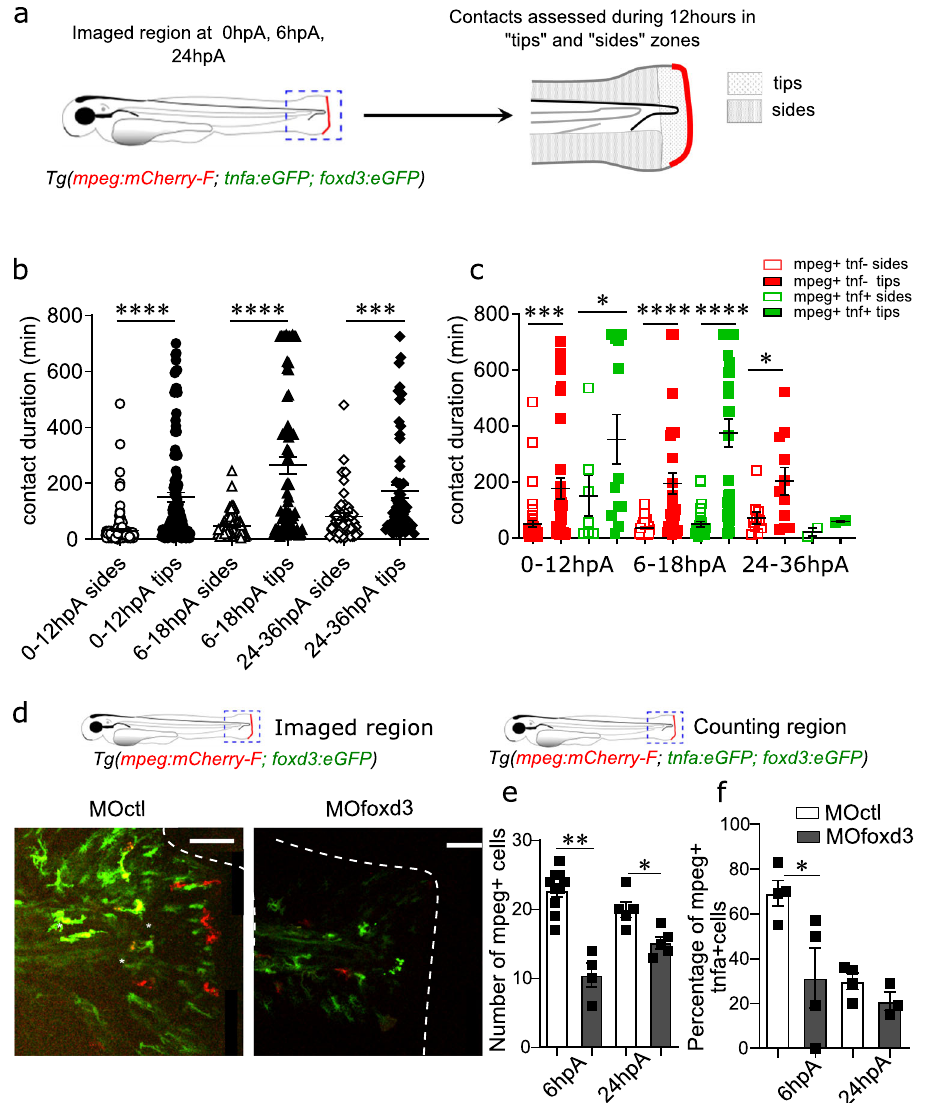
Fig. 4 Foxd3 + NCdC interact with and promote the recruitment and activation of macrophages in the blastema. a Schematic representation of the tip and sides where macrophages and foxd3 + NCdC contacts were assessed for 12 h by live confocal microscopy at 0hpA, 6 hpA, 24 hpA in Tg(mpeg:mCherry- F; tnfa:eGFP-F; foxd3:eGFP-F) larvae. b Quanti fi cation of the duration of macrophages and foxd3 + NCdC contacts in the tips and sides during 12 h in Tg(mpeg:mCherry-F; tnfa:eGFP-F; foxd3:eGFP-F) larvae, at 0hpA ( n = 192 for the sides group, n = 124 for the tips group), 6 hpA ( n = 105 for the sides group, n = 71 for the tips group), and 24 hpA ( n = 54 for the sides group, n = 60 for the tips group) (mean number of contact durations ± SEM, from at least n = 5 biologically independent larvae per time points, Kruskal Wallis test with Dunn ’ s test for multiple comparison were performed, **** p < 0.0001,). c Quanti fi cation of the contact duration between macrophages ( mpeg + and tnfa + ) and foxd3 + cells in tips and sides during 12 h in the transgenic larvae, at 0 hpA, 6 hpA, 24 hpA (mean number of contact durations ± SEM, Kruskal-Wallis test and Dunn ’ s test for multiple comparison were performed, * p < 0.05, *** p < 0.001, **** p < 0.0001, n = 3 biologically independent larvae per time point). d Fluorescence microscopy images of 3 dpf Tg(mpeg1:mCherry-F/ tnfa:eGFP-F/foxd3:eGFP-F) larvae injected with MO ctl or MO foxd3 (Scales bars = 50 µ m). e Number of macrophages recruited at the wound site at 6 hpA and 24 hpA in MO ctl- and MO foxd3 -injected Tg(mpeg1:mCherry-F) larvae (graph represents mean number of positive cells ± SEM, n = 10 biologically independent larvae for the control group at 6 hpA, n = 4 larvae for the MO foxd3 group at 6 hpA, n = 5 larvae for both control and morphant group at 24hpA, one-tailed Mann-Whitney test was performed, p = 0.0028 for the 6 hpA time point, p = 0.0106 for the 24 hpA time point, * p < 0.05, ** p < 0.01). f Percentage of pro-in fl ammatory macrophages at the wound site at 6 hpA and 24 hpA (graph represents mean number of mpeg + tnfa + cells ± SEM, n = 4 biologically independent larvae per groups , one − tailed Mann-Whitney test was performed, p = 0.0286 for the 6 hpA time point, * p < F/tnfa:eGFP-F/foxd3:eGFP-F) 3 dpf larvae, we monitored the long-lasting contacts occurred preferentially in the tip region interactions between foxd3 + NCdC and macrophage subpopula- (Fig. 4b). Moreover, the long-lasting contacts in the fi n fold tips were more frequent between foxd3 + NCdC and tnfa + macro- tions at different time points during regeneration (0, 6, 24 hpA) phages (Fig. 4c, Movie 2). This result showed that contact fre- using confocal microscopy (12 hours of live imaging), and quency and duration between macrophages and foxd3 + NCdC quanti fi ed the interactions between these cell types in two dif- depend on the region of the regenerating blastema. The fi nding that ferent regions of the fi n fold (tip and sides) (Fig. 4a). We found long-lasting contacts were preferentially made by pro-in fl ammatory that macrophages and foxd3 + NCdC had many contacts, and that